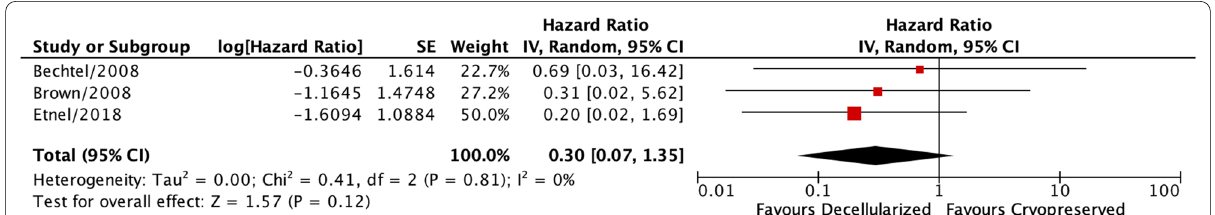
Fig. 5 Forest plot comparing follow-up endocarditis in decellularized allografts versus cryopreserved allografts for patients undergoing right ventricular outflow tract reconstruction during the Ross procedure. IV inverse variance, CI confidence